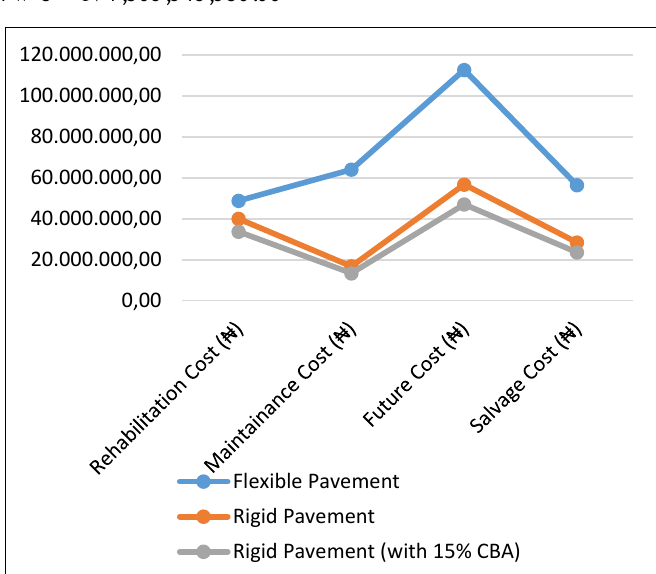
Figure 2: Agency costs for varying pavement